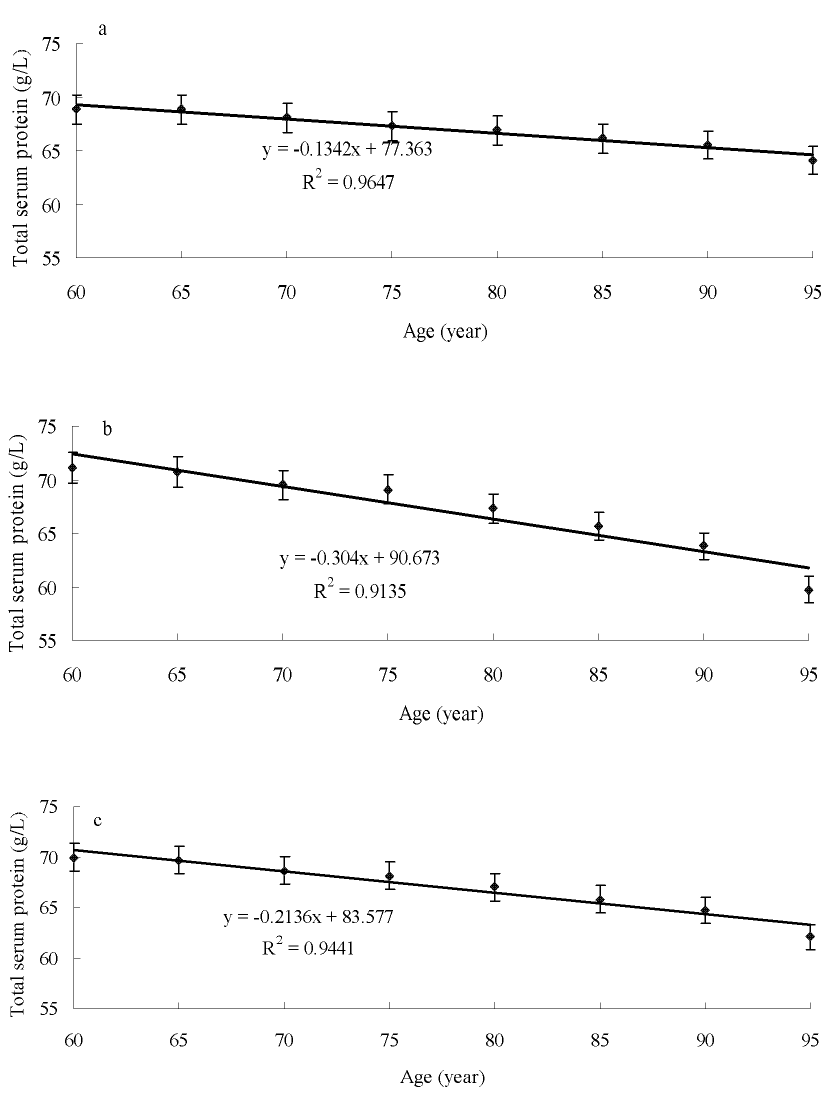
Figure 3. Association of total protein levels with age in male (a), female (b), and overall (c) groups aged $ 60.